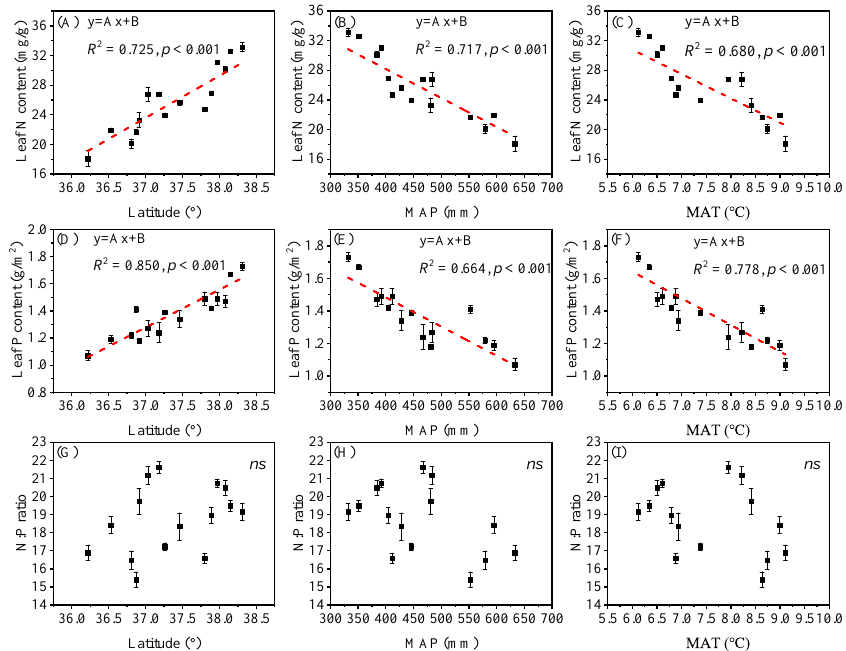
Figure 3. Linear regression relationships of Leaf N, P and the leaf N/P ratio with MAT, MAP and absolute latitude. Note: ( A – C ), Leaf N: leaf nitrogen content; ( D – F ), Leaf P: Leaf phosphorus content; ( G – I ), N:P ratio: Leaf N/P ratio. The red lines indicate the fits of the linear model of Leaf N, P and the leaf N/P ratio and environmental gradient (latitude, MAT and MAP). All climate data (MAT and MAP) was obtained from China Meteorological Data Sharing Service System (http://data.cma.cn/ (accessed on 10 May